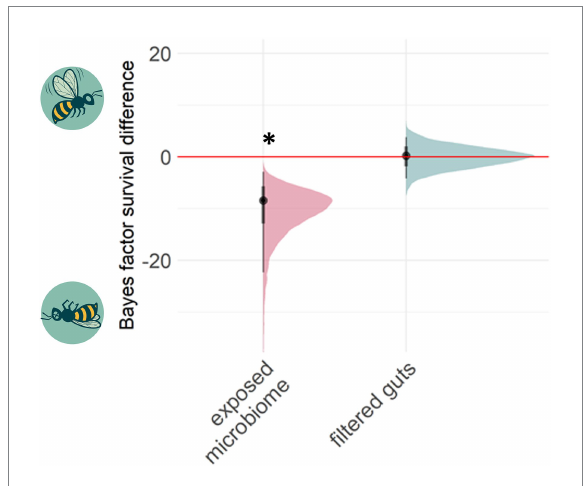
FIGURE 3 Past chemical exposure of a microbiome can affect future host survival. The Bayes factor difference between treatment and control groups measures whether survival in treatments was higher (positive axis) or lower (negative) under a high dose of tetracycline relative to the respective control group. 95% posterior distribution confidence intervals lying outside zero are highlighted by asterisks. Transferring tetracycline pre-exposed guts ( N = 3 cages; altogether 53 control-gut and 47 tetracycline- gut individuals) negatively affected bee health under high stress, while transferring filtered gut solution together with a healthy adult microbiome ( N = 4 cages; altogether 60 control-filter-gut and 50 tetracycline-filter-gut individuals) did not affect the